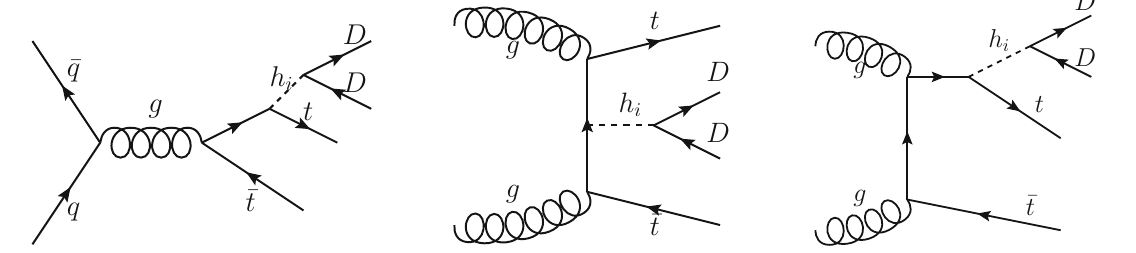
Fig. 1 Dominant t ¯ t + DM associated production processes. The DM particle is denoted as D for generic case without specifying the spin